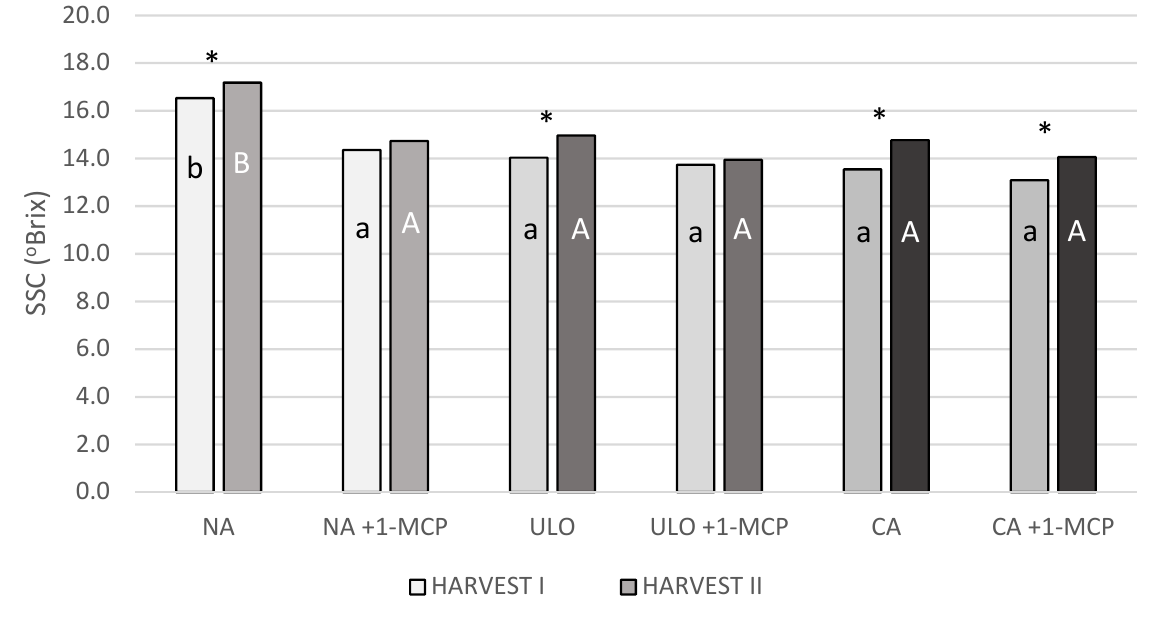
Figure 3. Soluble solids content of ‘Geneva’ fruit ( ◦ Brix) depending on harvest time and 1-MCP treatment under three storage technologies. Statistically significant difference between first and second harvest fruit (Newman–Keuls range test): *—for 5%. Different letters were assigned to statistically significant differences when comparing the effect of 1-MCP, separately for storage conditions.